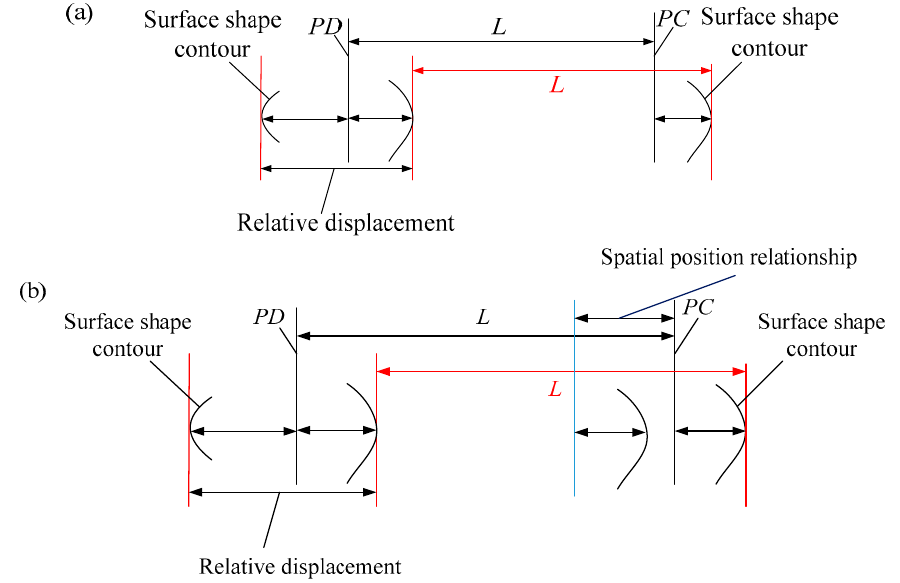
Figure 10. Geometric model of PC and PD cross section direction: ( a ) Positional relation does not exists between PC and PD surfaces. ( b )Positional relation exists between PC and PD surfaces.